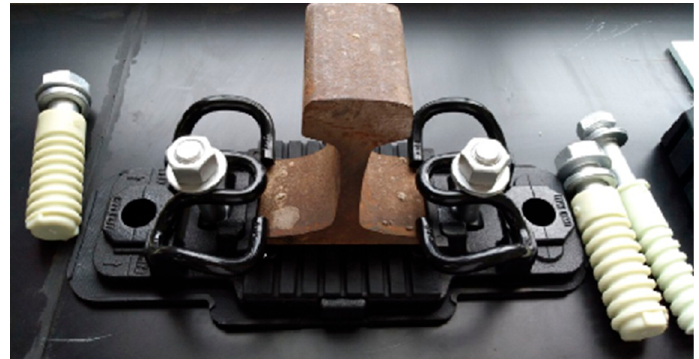
Figure 4. A typical WJ-7 small resistance fastener